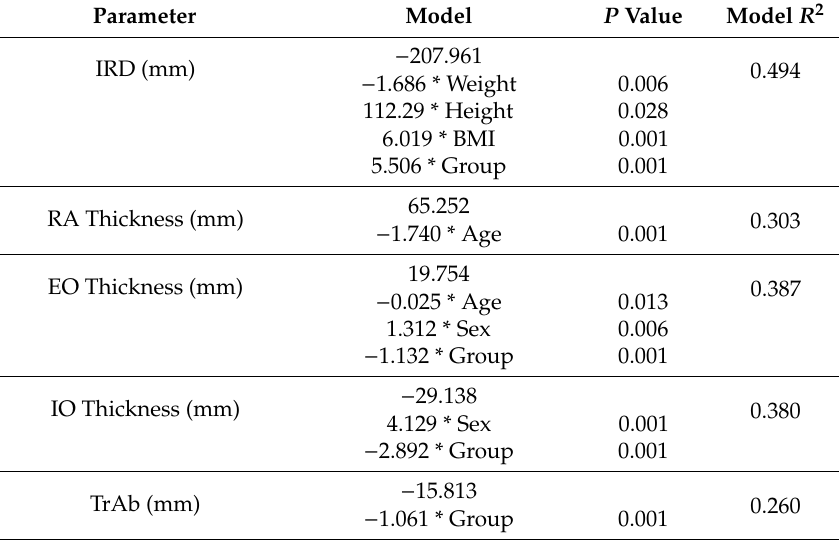
Table 3. Multivariate predictive analysis for IRD, EO, and multifidus thickness for patients with Achilles tendinopathy and